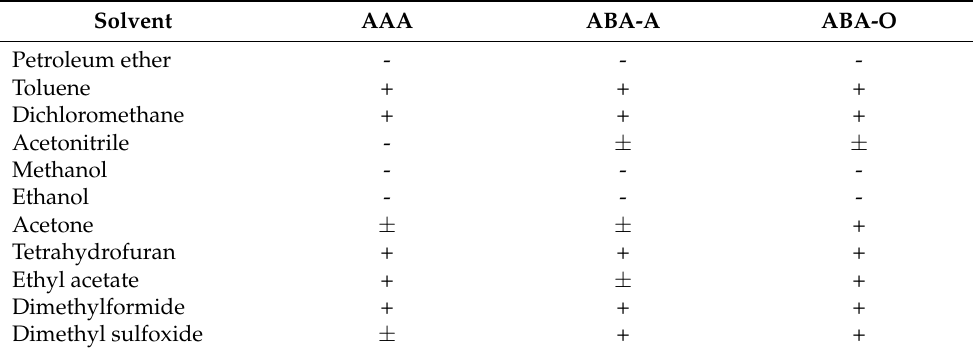
Table 2. Solubility of three